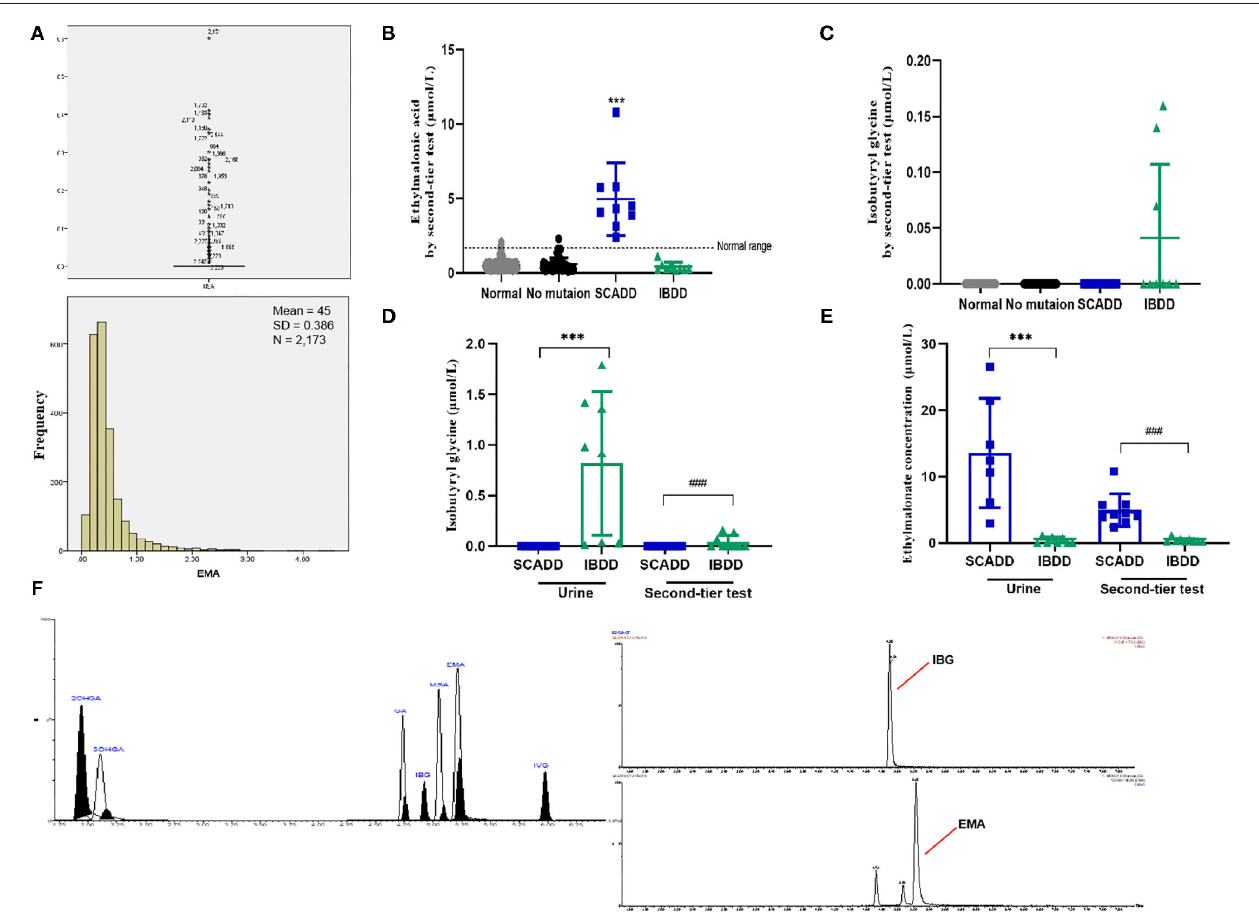
FIGURE 4 | Metabolite levels identified by the second-tier test and urinary GC/MS. (A) Statistical analyses of outliers and normal distribution results for EMA. (B) Second-tier test for EMA in DBSs. (C) Second-tier test for IBG in DBSs. (D) EMA concentrations in individuals with SCADD/IBDD determined by the second-tier test and urinary GC/MS. (E) IBG concentrations in individuals with SCADD/IBDD determined using the second-tier test and urinary GC/MS. (F) Chromatographic separation of several acylcarnitines. Calibration curve, points constructed from 11 standardized acylcarnitines. The following acylcarnitine species were extracted from